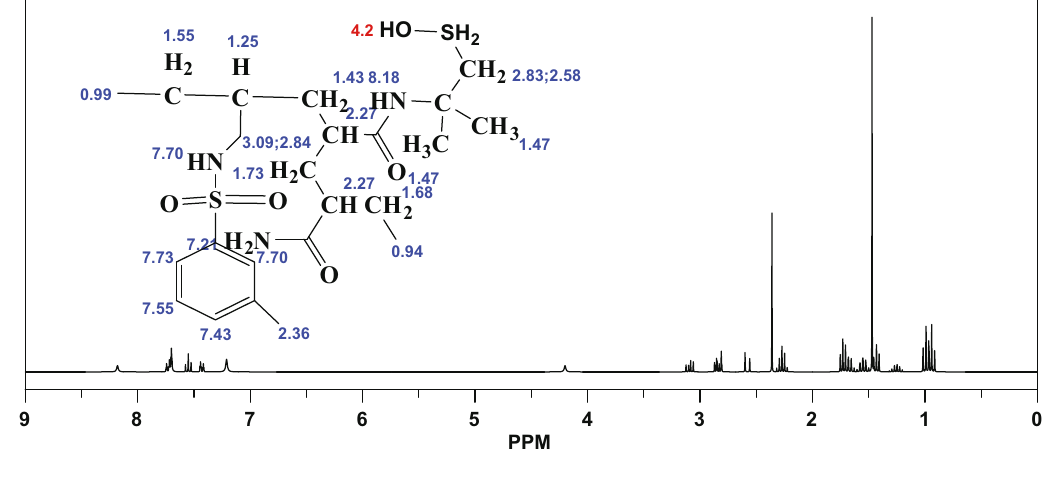
Figure 3: 1 H - NMR spectrum of nano - silica gelling